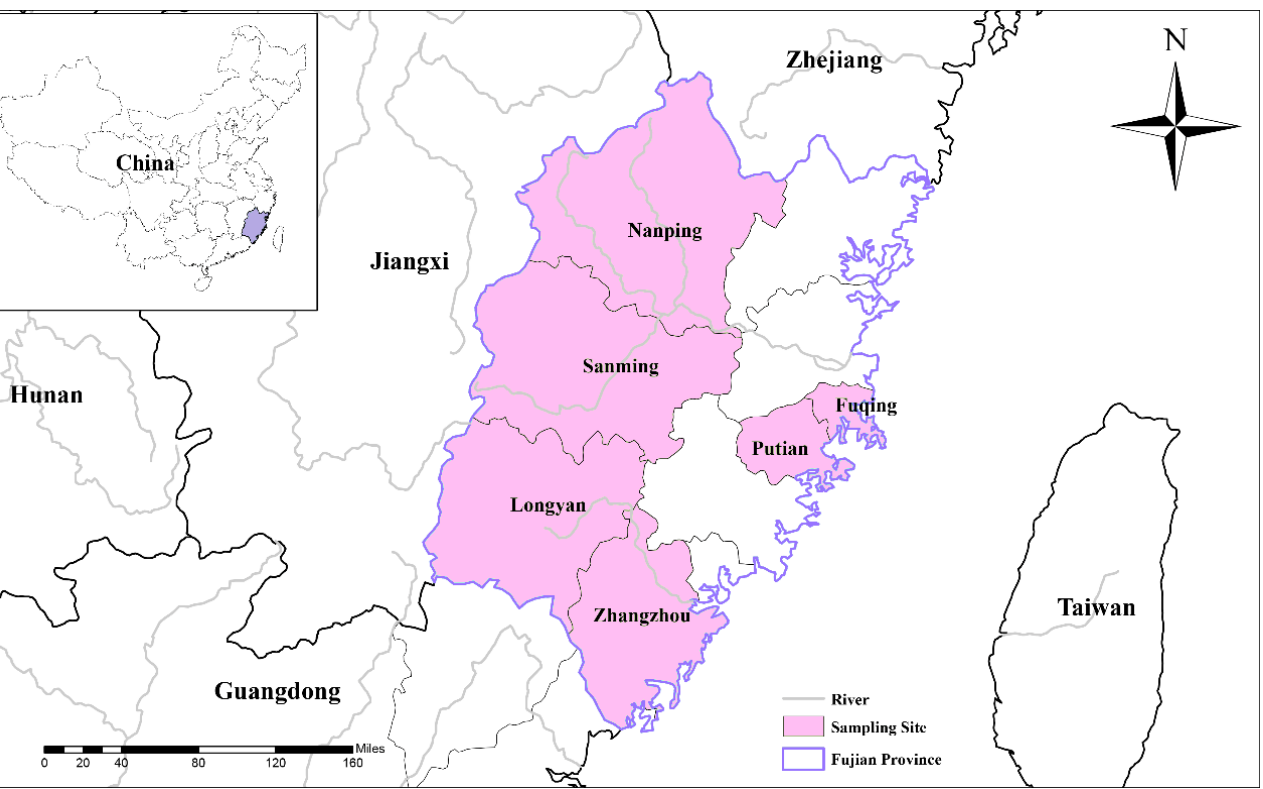
Figure 1. Geographic distribution of sampling sites in Fujian Province, southeastern China.